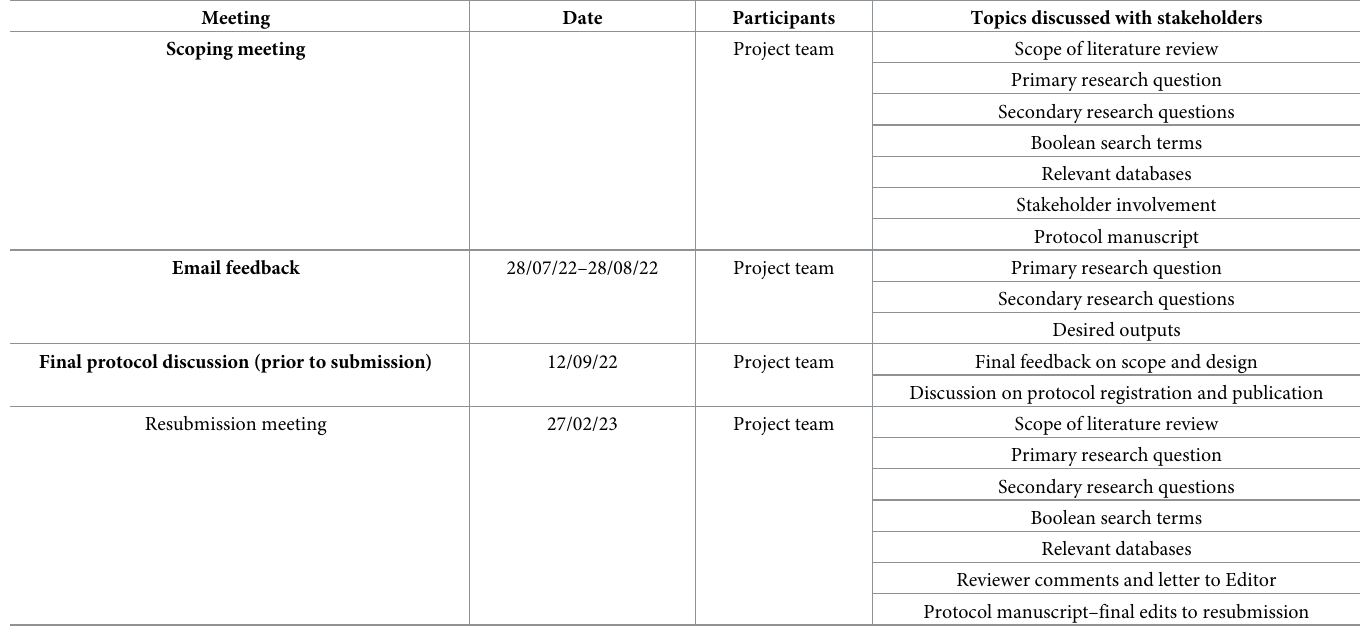
Table 1. Timeline of project team and stakeholder consultation for the development of the systematic literature review protocol.